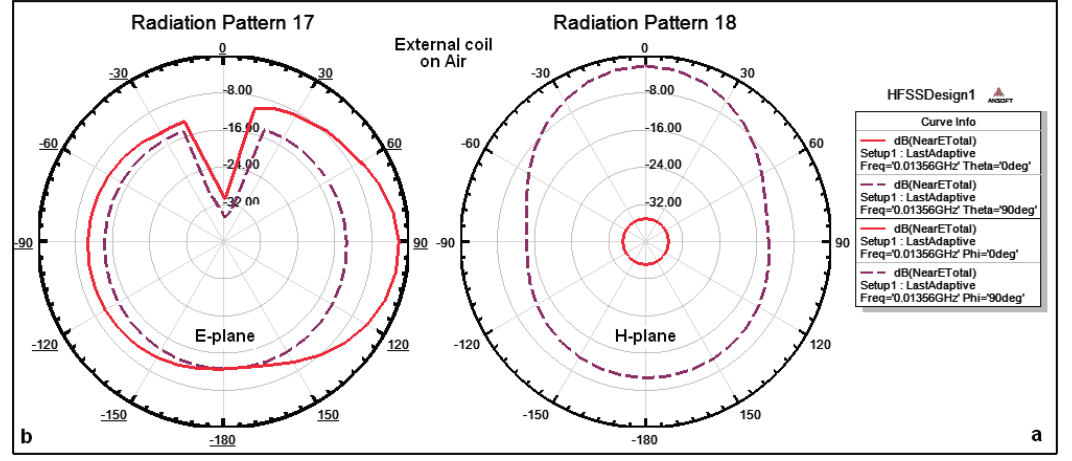
Figure 7. Simulated patterns for total near field surrounding external coil on air: ( a ) on the azimuthal plane ( θ = 0°, θ = 90°); ( b ) on the elevation plane ( Φ = 0°, Φ = 90°),